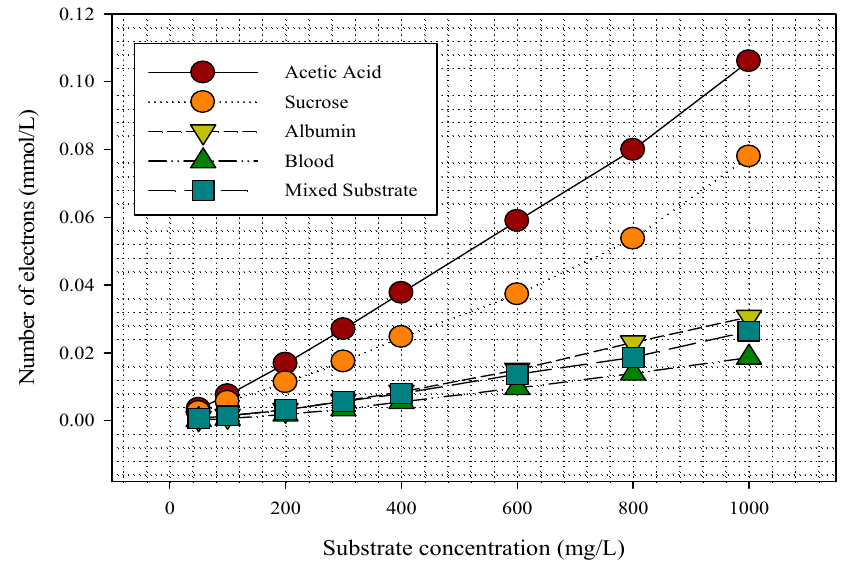
Figure 6. Number of electrons expected to be accepted at the anode.